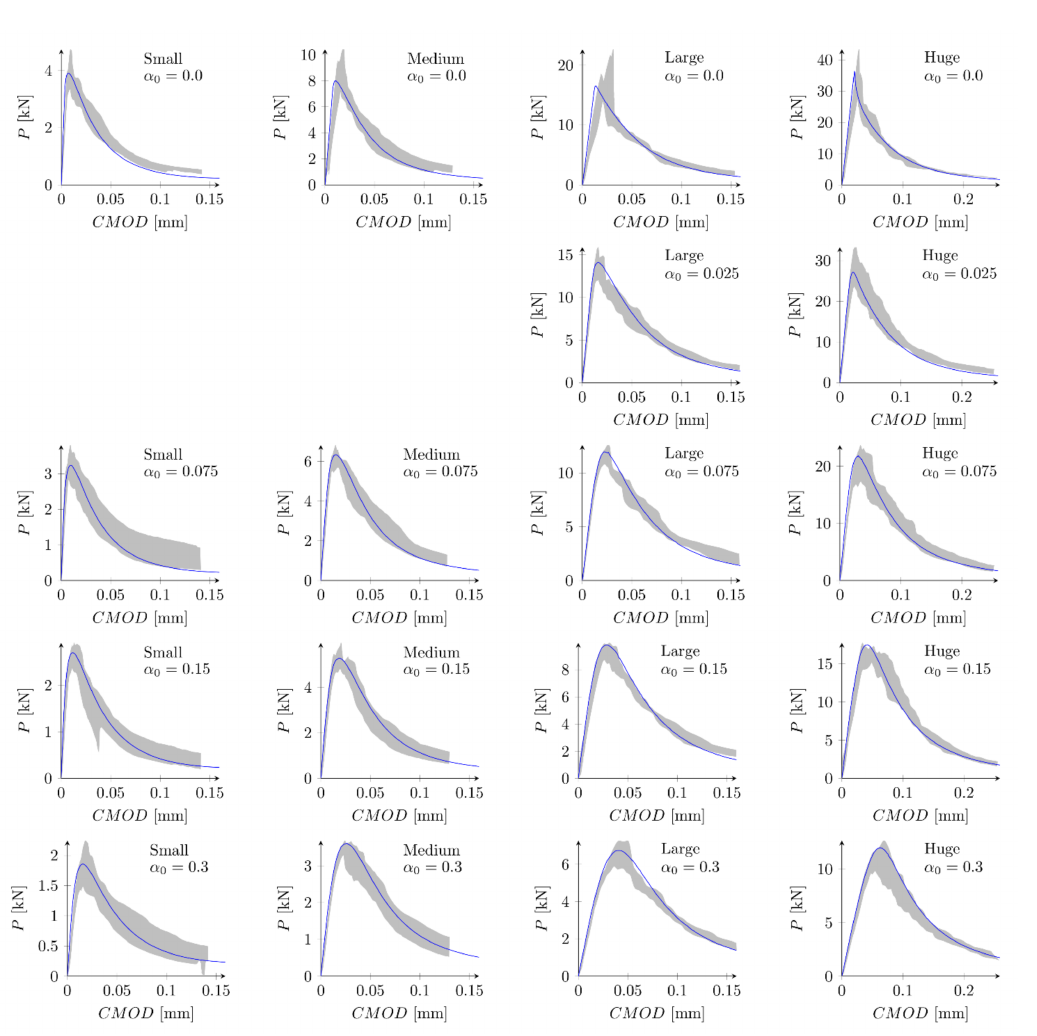
Figure 13. Experimental and numerical force-crack mouth opening displacement curves for exponen- tial softening and set S11: f t = 5.2 MPa, G f = 35 N/m, b = 1 cm, β 0 = 0.6.